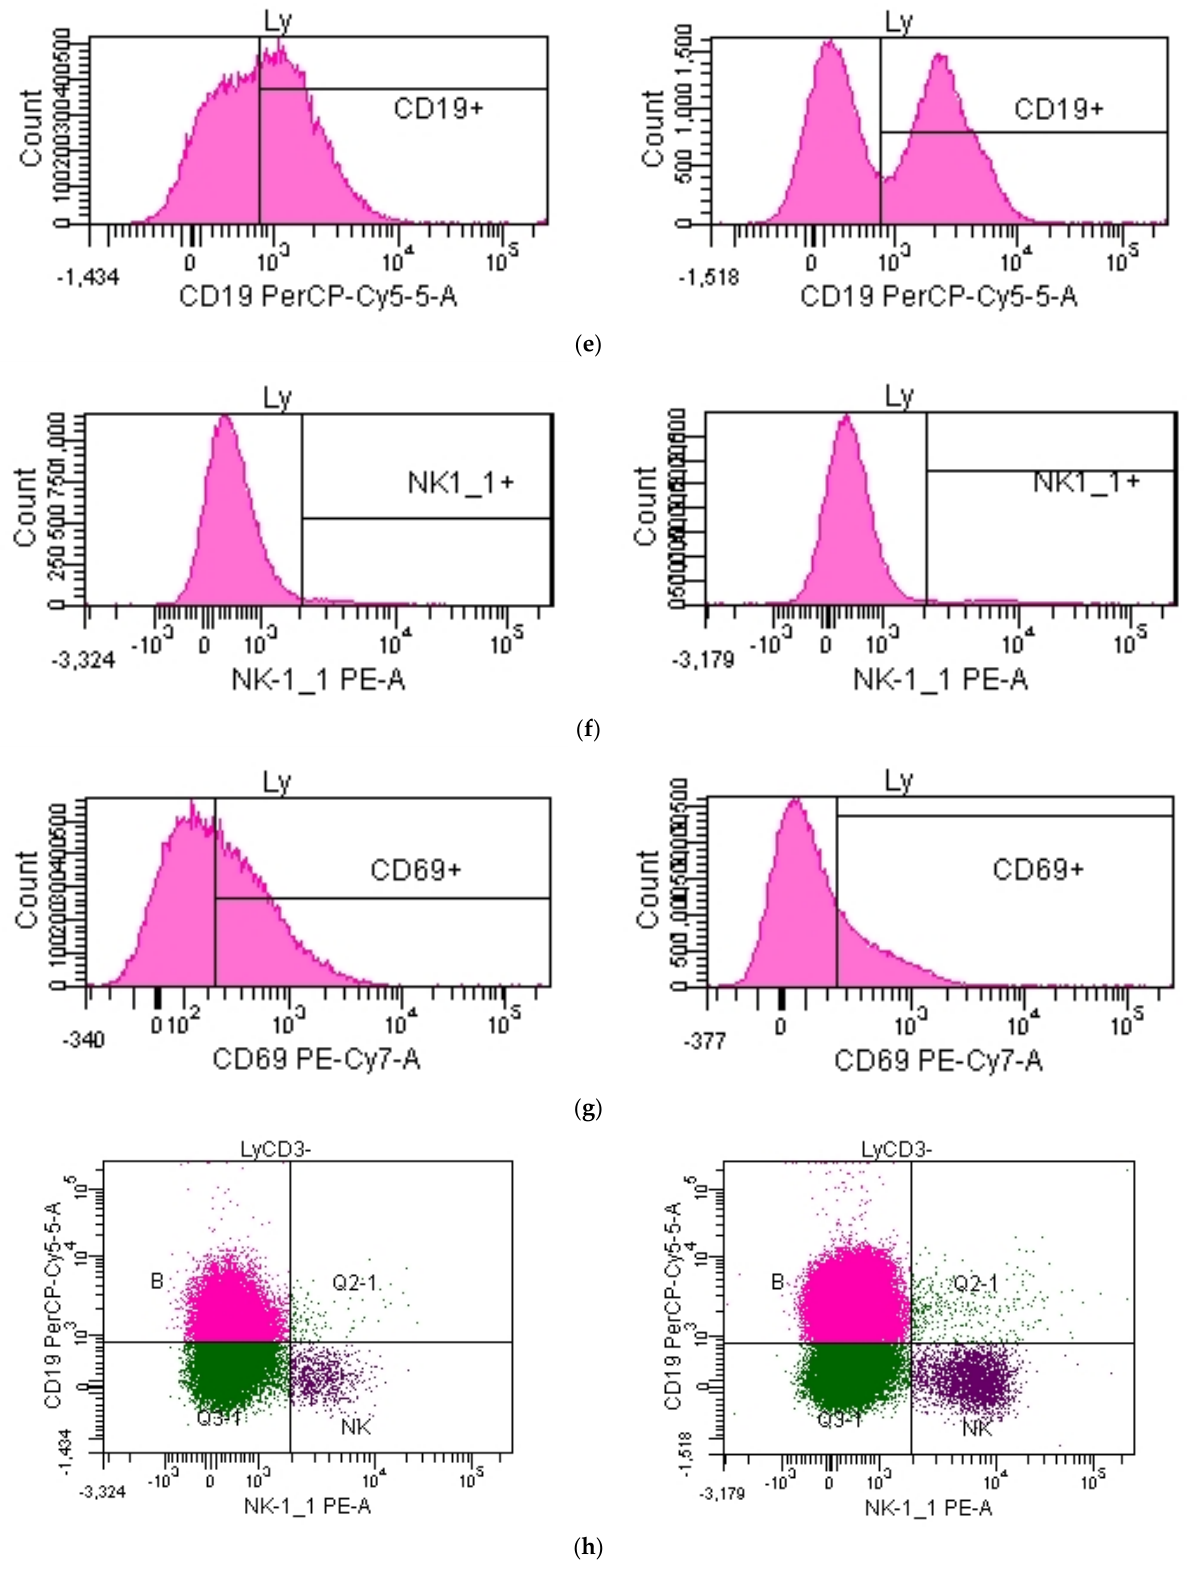
Figure 7. ( a ) Selection of singlet events. ( b ) Selection of the lymphocyte population. ( c ) Selection of lymphocytes of CD3ε+. ( d ) Selection of lymphocytes of CD8a+. ( e ) Selection of B lymphocytes. ( f ) Selection of NK cells. ( g ) Selection of lymphocytes of CD69+. ( h ) Selection of B lymphocytes and NK